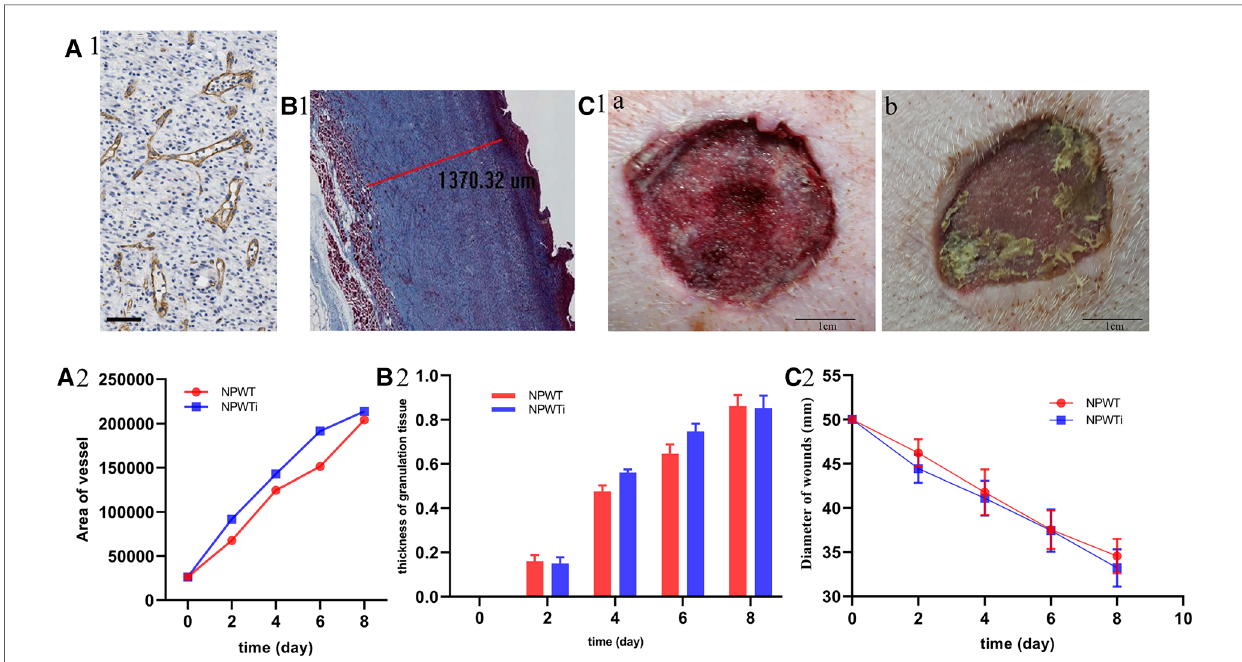
FIGURE 7 Histologic parameters and wound healing. ( A ) The difference of area of neovascularization between two groups and the scale bar was 100 um. ( B ) The difference of thickness of new granulation. ( C ) The difference of gap of wounds between two groups. Area of neovascularization and the thickness of new granulation tissue showed that it was signi fi cant larger in NPWTi group compared with NPWT on day4 and day6 ( P <0.05). No signi fi cant difference was observed between two groups on day 2, 4, 6, and day 8 with respect to wound gap ( P